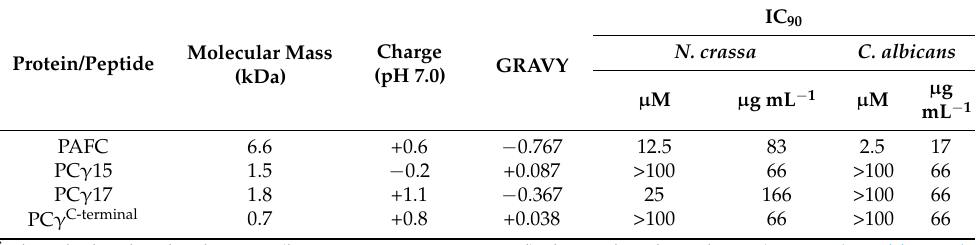
Table 4. Physicochemical characteristics and the fungal growth inhibitory potential (IC 90 ) of the peptides PC γ 15, PC γ 17, and PC γ C-terminal compared to the full-length MP PAFC § .